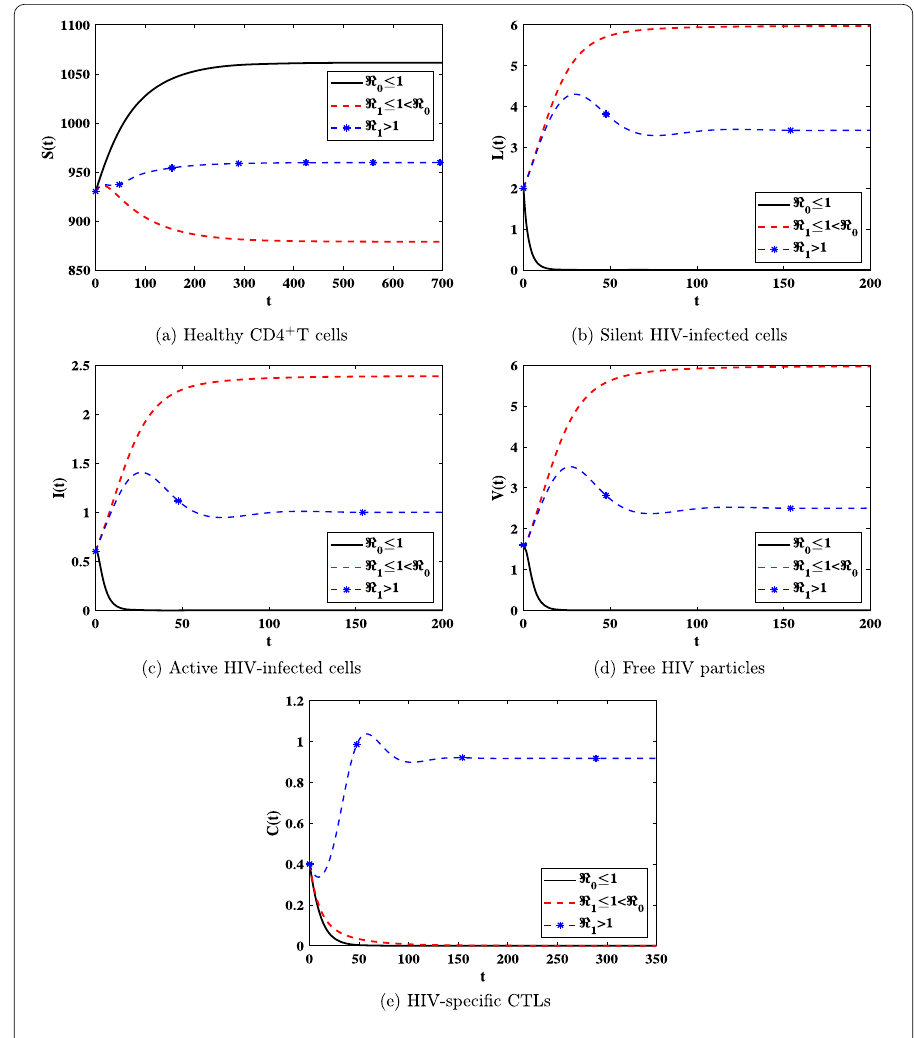
Figure 1 The behavior of solution trajectories of system (28)